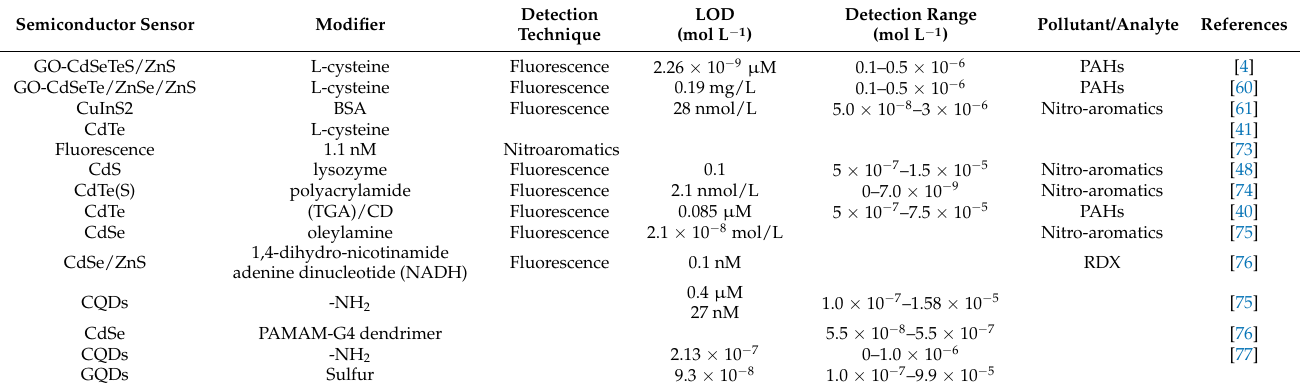
Table 1. Effect of different materials on the limit of detection of polycyclic aromatic hydrocarbons and nitro-aromatic compounds. Semiconductor